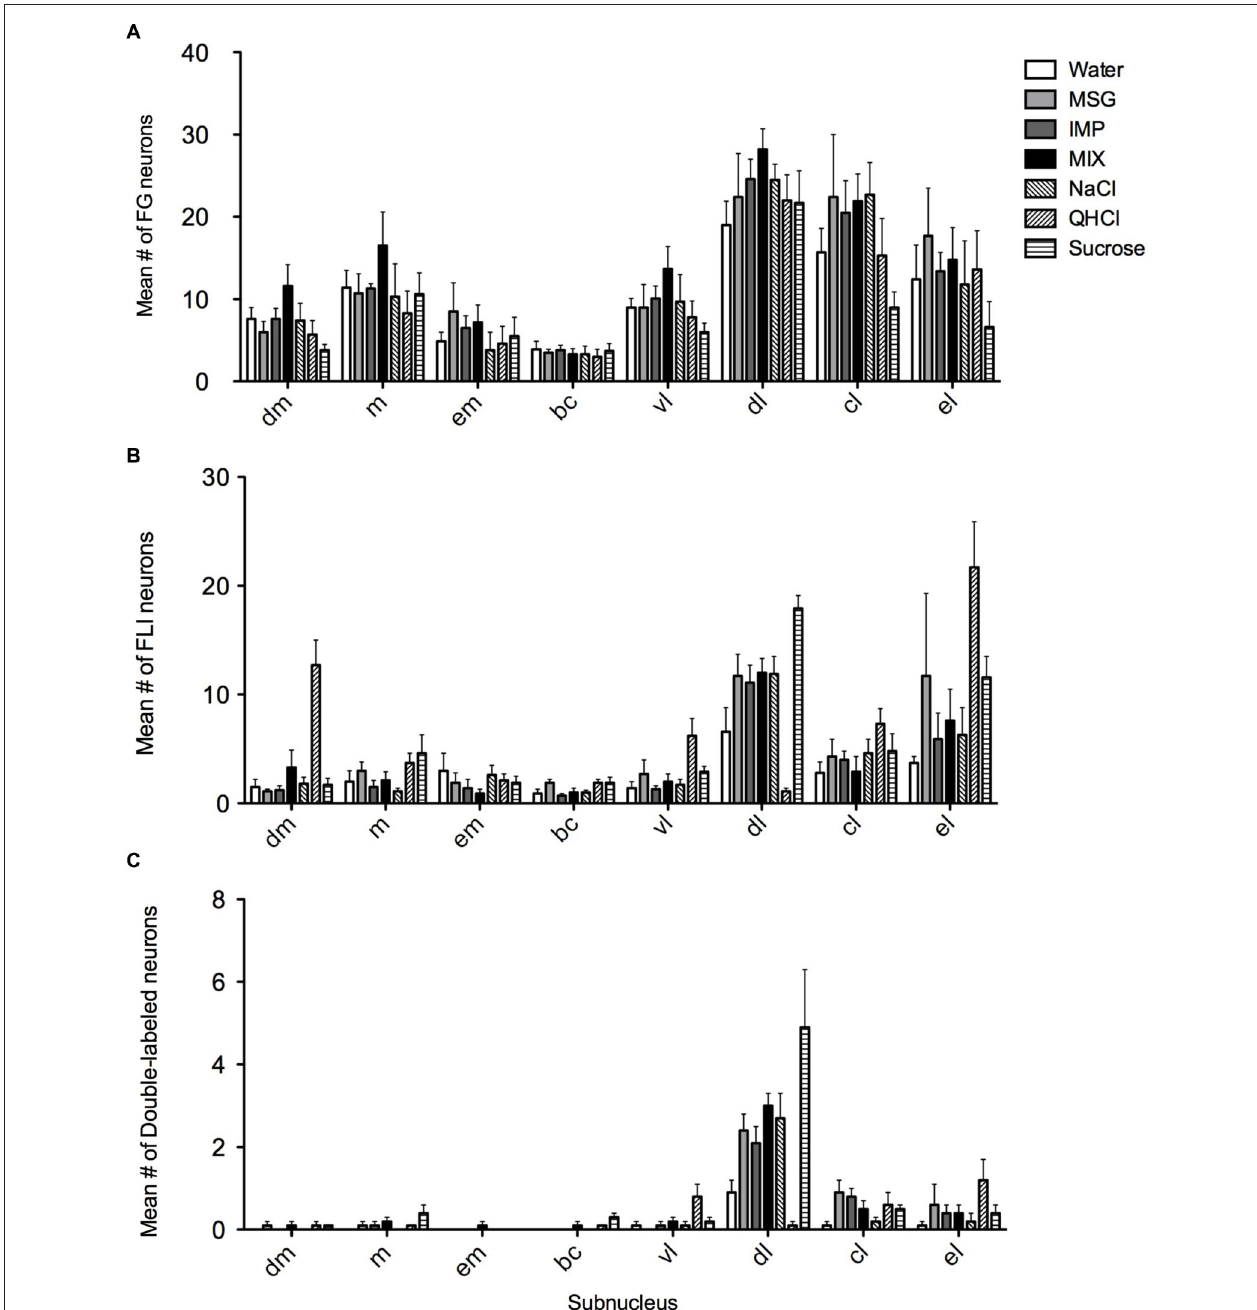
FIGURE 5 | Quantification of FG, FLI and double labeling in the PbN by subnucleus. (A) Mean numbers of LH-projecting neurons varied according to subnucleus but not across stimulus groups. (B) Mean numbers of FLI neurons varied among stimuli in some subnuclei, as did double-labeled cells (C) .